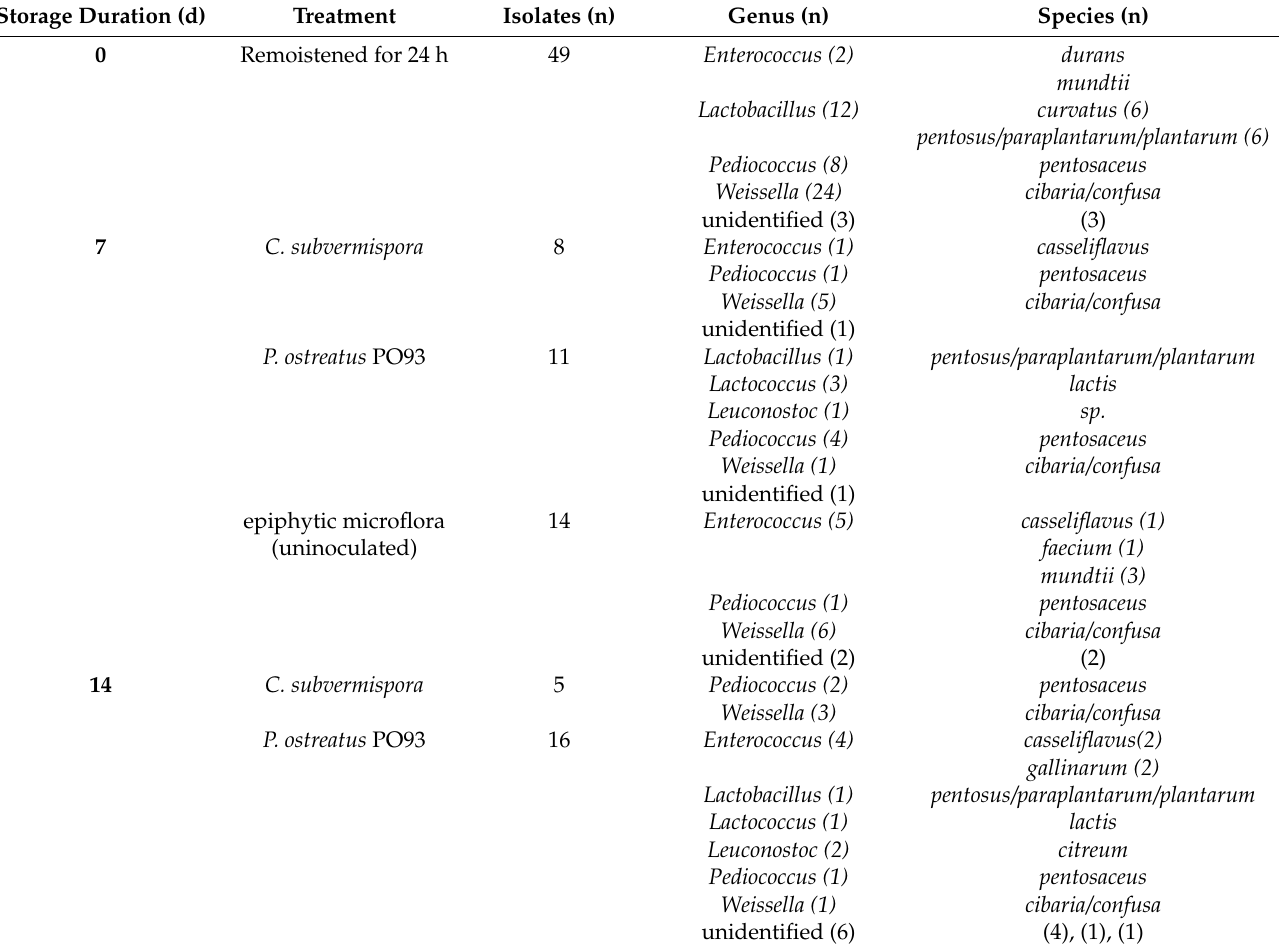
Table 2. Lactic acid bacteria species identified by MALDI-TOF and number of their isolates from remoistened straw at different incubation